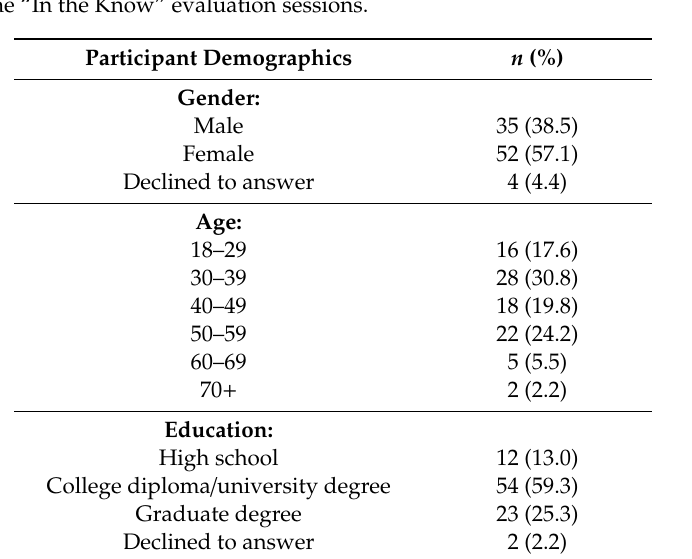
Table 1. Demographic information ( n = 91) for Canadian agricultural community members who participated in the “In the Know” evaluation